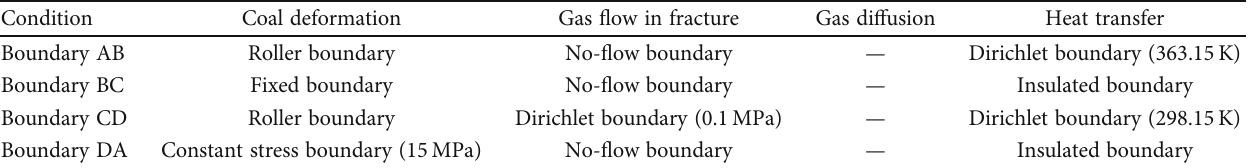
Figure 9: Con fi guration of the fi ve-spot pattern well for thermally enhanced CBM recovery. Table 3: Boundary conditions of the computational